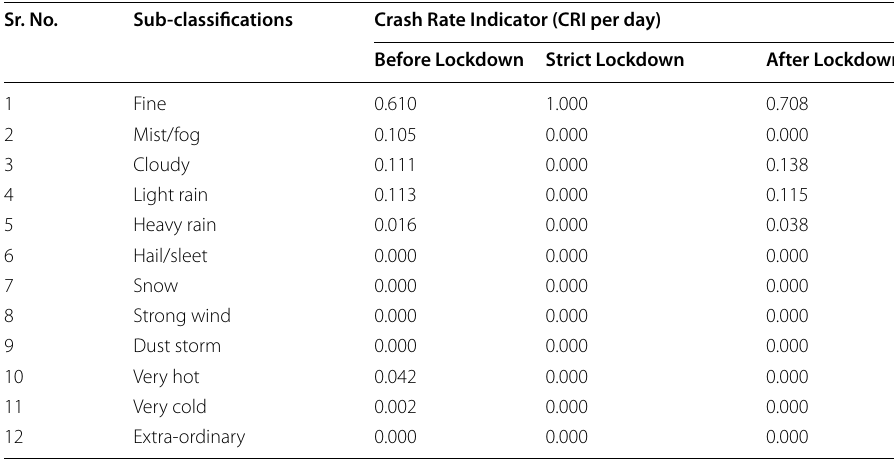
Table 9 CRI by weather